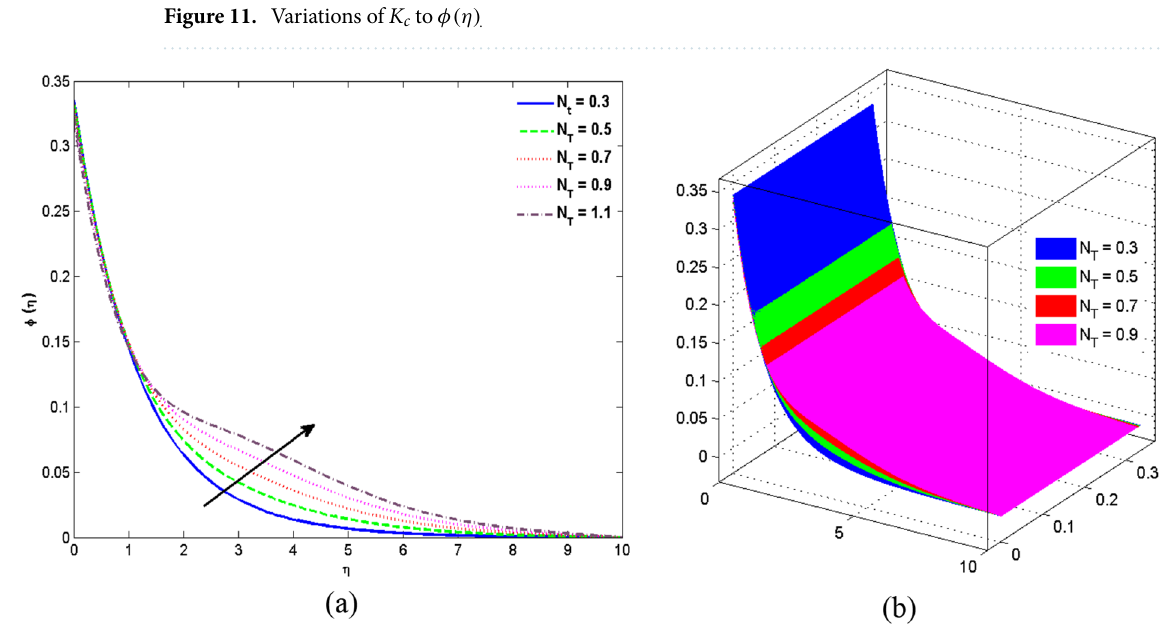
Figure 12. Variations of N T to φ(η)